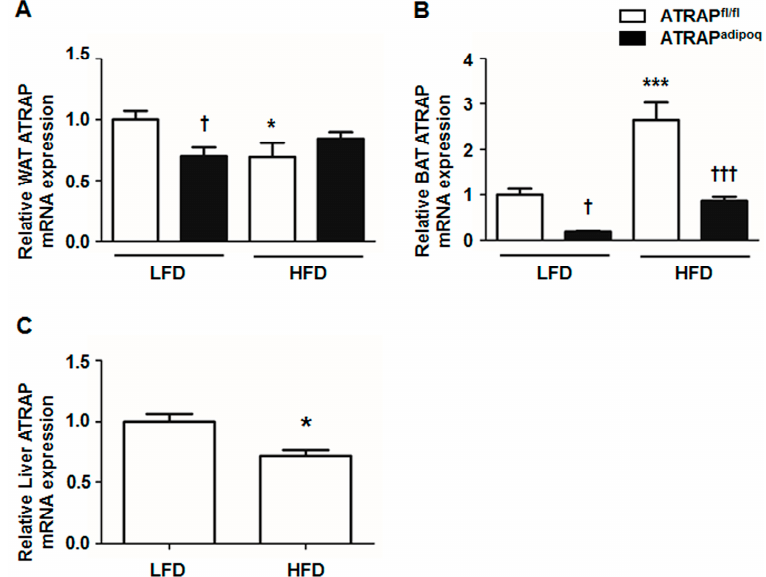
Figure 6. The changes of ATRAP expression in adipose tissues and liver with HFD. ( A ) Relative WAT ATRAP mRNA expression in ATRAP fl/fl and ATRAP adipoq mice fed an LFD and HFD ( n = 6). ( B ) Relative BAT ATRAP mRNA expression in ATRAP fl/fl and ATRAP adipoq mice fed an LFD and HFD ( n = 6). Relative liver ATRAP mRNA expression in ATRAP fl/fl mice fed an LFD and HFD ( n = 6). Values are the means ± SEM. (A, B) † p < 0.05, ††† p < 0.001 vs. ATRAP fl/fl mice on the same diet. * p < 0.05,